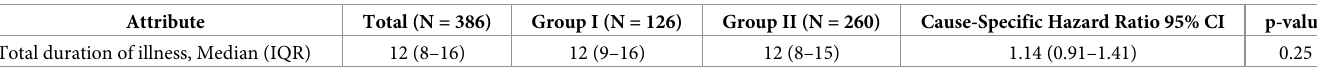
Table 2. Duration of illness of COVID-19 patients among Group I and Group